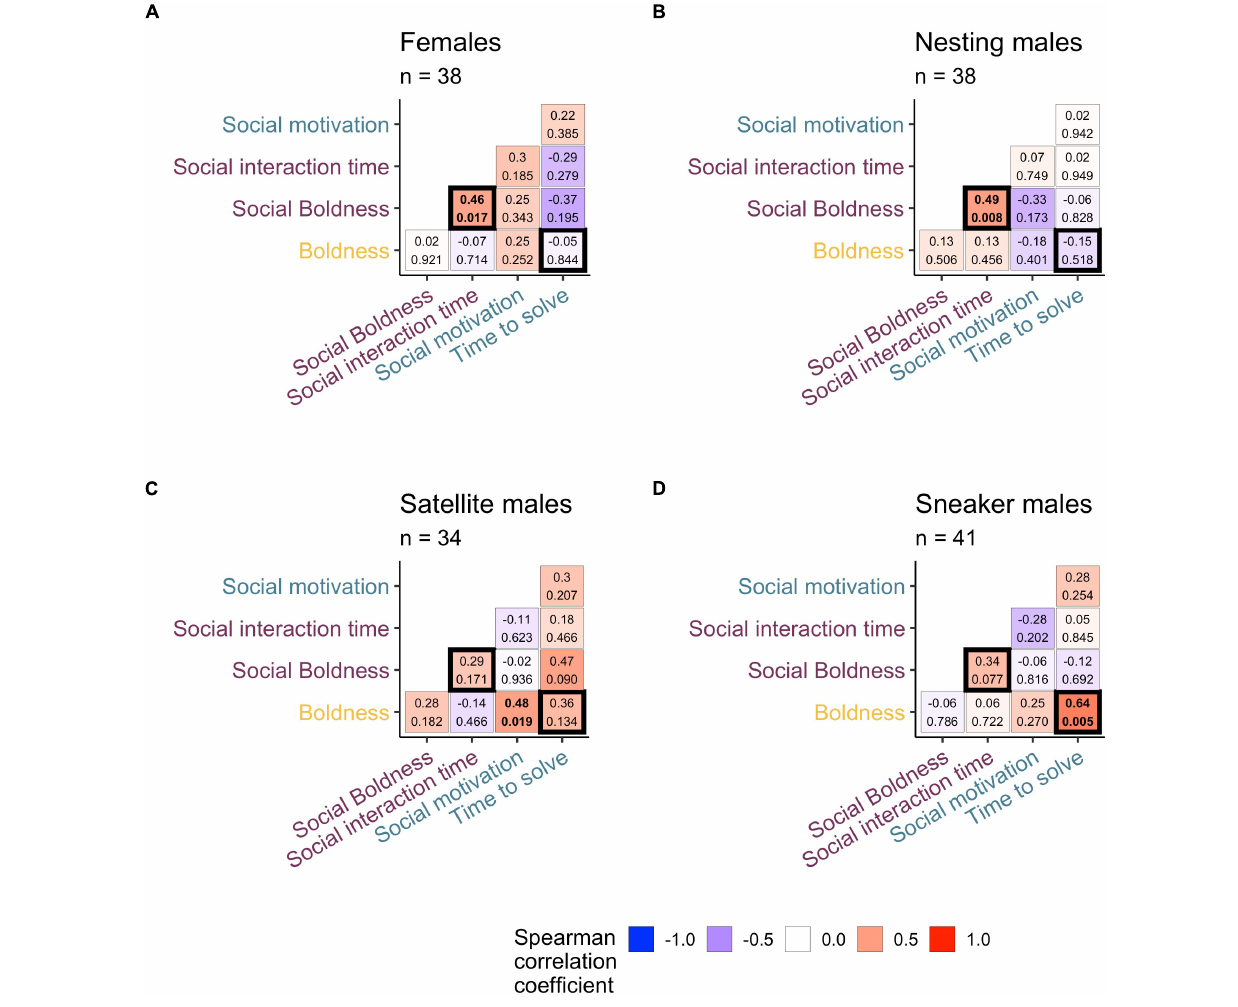
FIGURE 2 | Heatmap of pairwise correlations (spearman) across all behavior metrics and detour problem-solving performance for females (A) , nesting males (B) , satellite males (C) , and sneaker males (D) . Each matrix box includes the spearman correlation coefficient on top and the p value on the bottom. Matrix labels are color coded t indicate which behavior assay each measurement was derived from (detour assay in teal, shoaling assay in dark purple, scototaxis in gold). Cells outlined in bold represent significant interaction terms (behavior × phenotype, p < 0.05) in generalized linear mixed